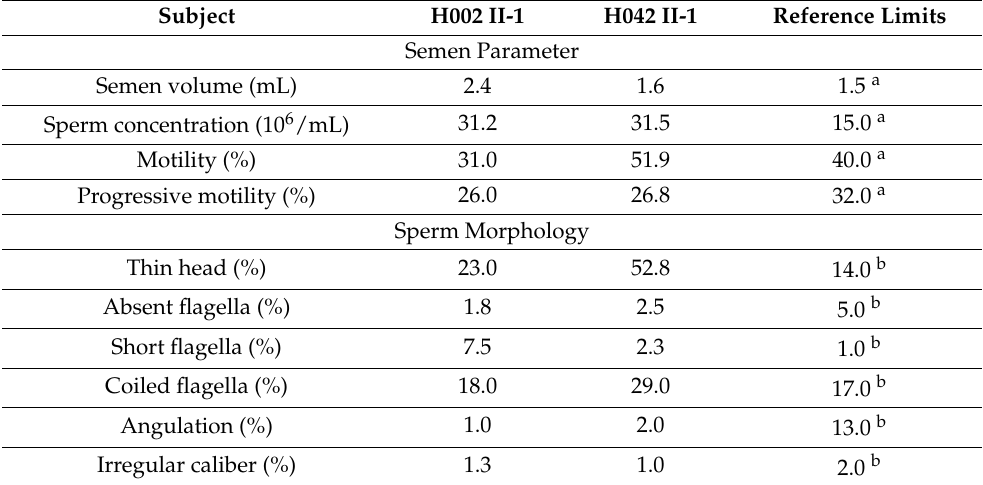
Table 2. Semen characteristics and sperm morphology in men harboring hemizygous USP26 variants.